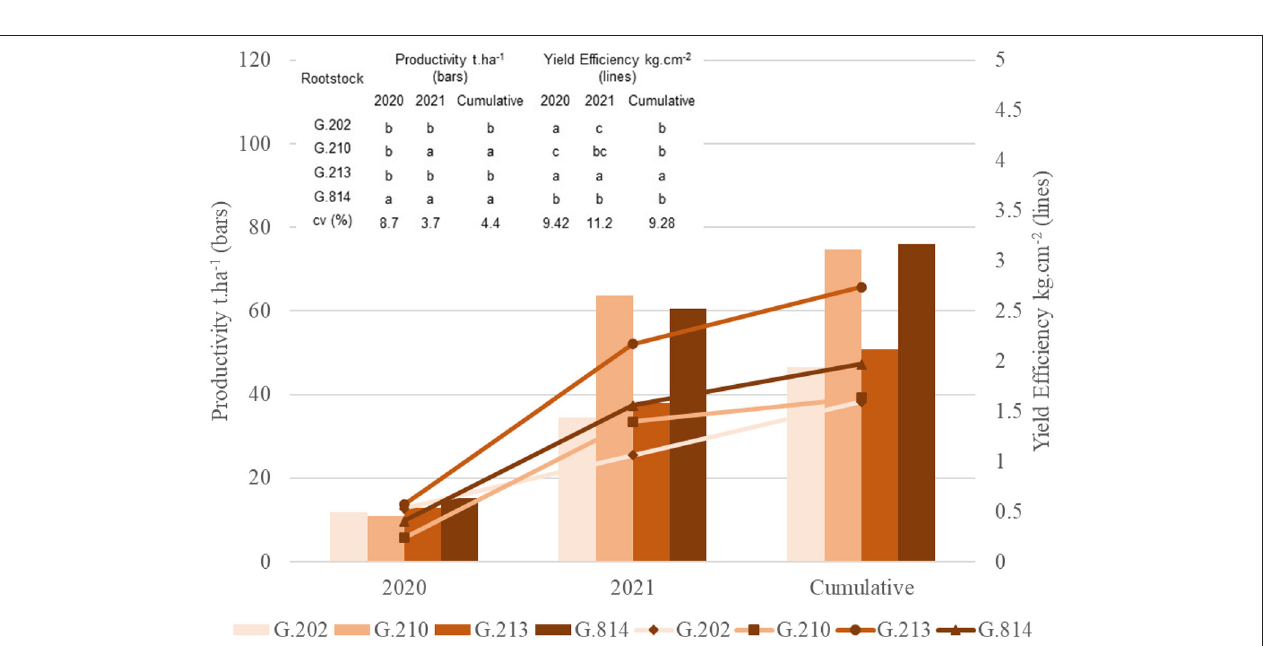
FIGURE 8 | Yield and yield efficiency of the Fuji Suprema cultivar grafted on different rootstocks, under replanting area in Vacaria. Yield and yield efficiency that do not share a letter are significantly different (Tukey’s test, α = 0.05).